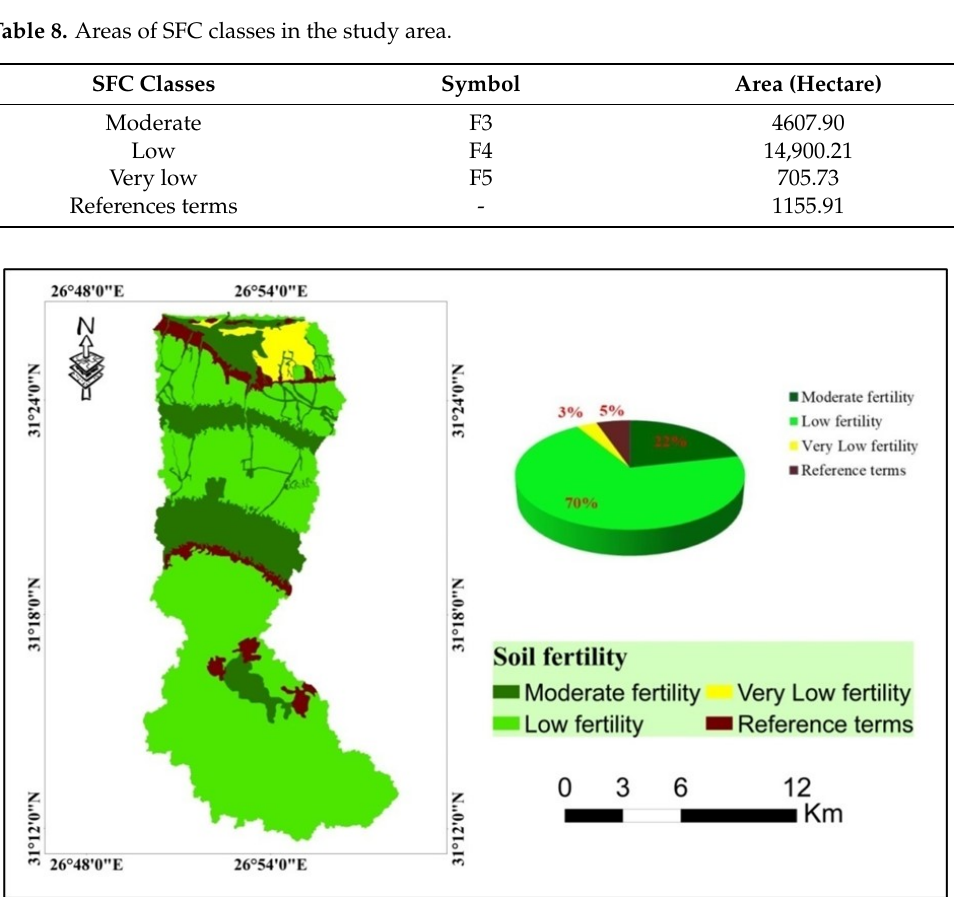
Figure 1. Schematic diagram of current work methodology; note: MLR = multi linear regression . 2.1. Study Area The experimental area is located in the western part of Matrouh Governorate, Egypt, between longitudes 26°49 ′ 58.0”and 26°58 ′ 06” East, and latitudes 31°13 ′ 07”and 31°26 ′ 36’’ North with a total area of 213.7 km 2 (Figure 2). The study area has a wide variety of en- vironmental conditions [43,44] and is characterized by a Mediterranean Sea climate, with rainfall fluctuating between 105 and 200 mm per day and the mean temperatures of 8.1 to 18 °C and 20 to 29.2 °C in the winter and summer seasons, respectively [6]. The area suf- fers from low-density vegetation cover during the summer, with the vegetation cover